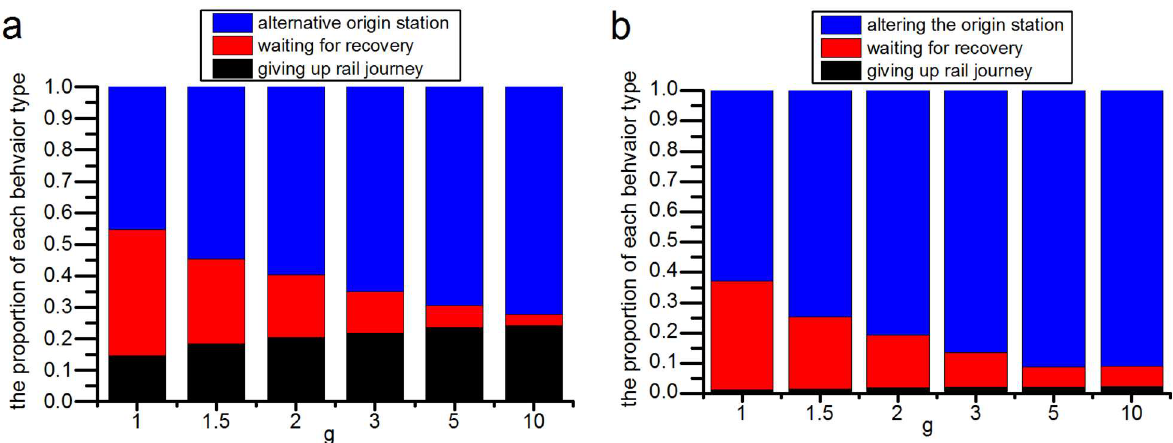
Fig 17. The relationship between the overestimation of the closure duration and the passenger behavioral choices. (a) shows the proportionof passengerbehavioral choices after the station closure in the JISHUITAN case. (b) shows the proportionof passenger behavioral choices after the TIANTONGYUAN station is closed in the second closurecase. With increasing g , the numberof passengers taking an alternativeorigin station or giving up on their rail transit journeygraduallyincreases.